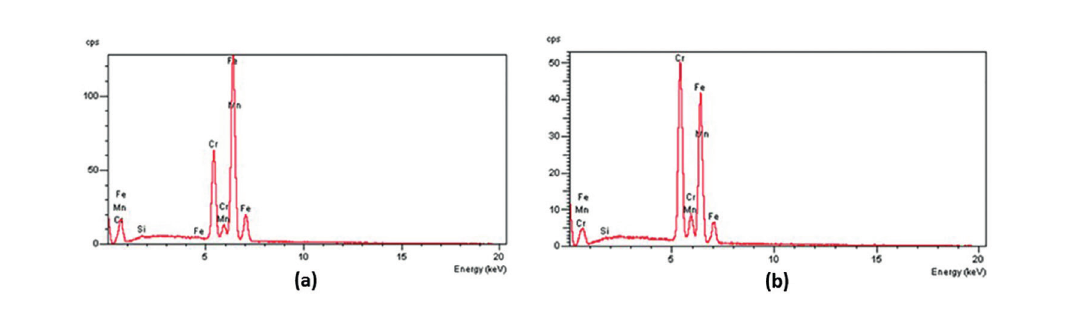
Figure 9: EDS of the Fe-Cr-C hardfacing on (a) eutectic matrix and (b) primary carbides.